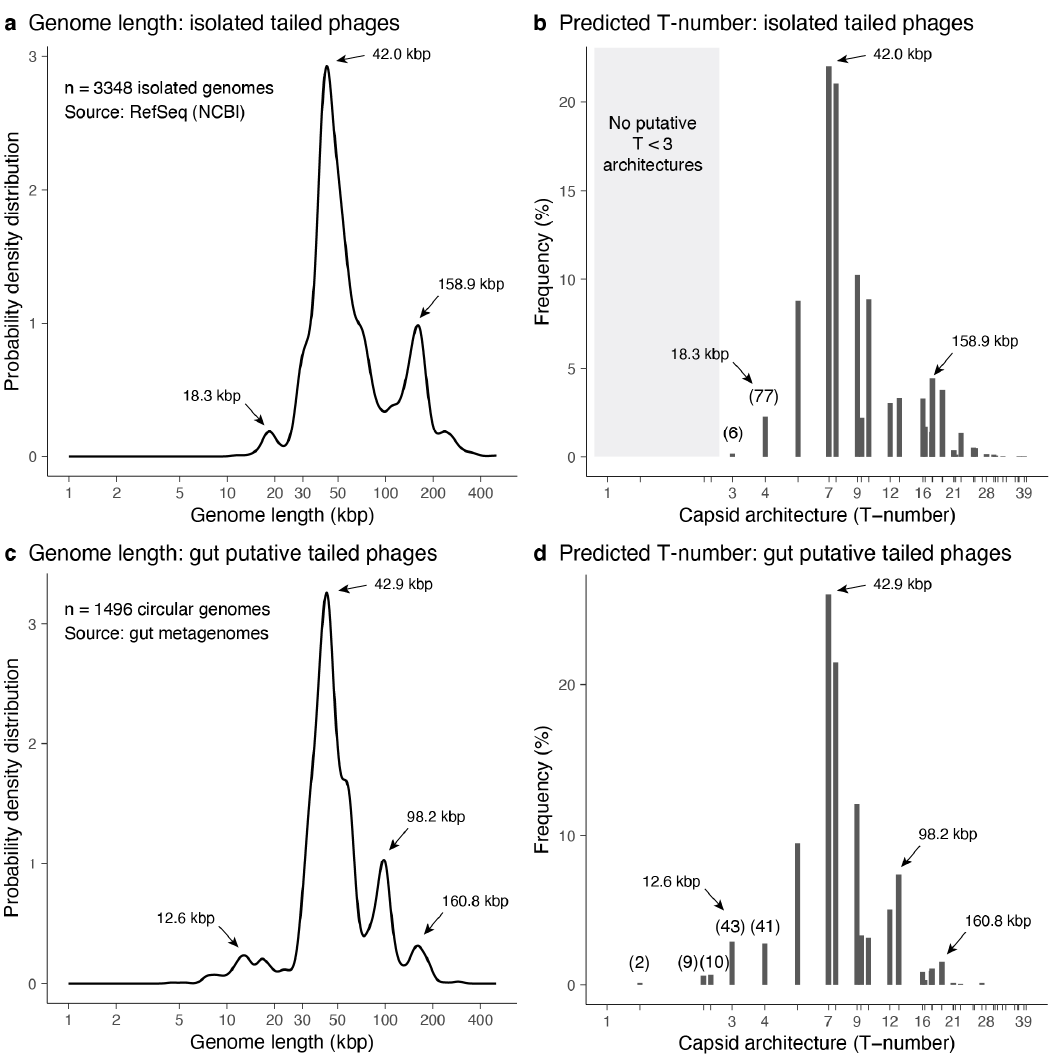
Figure 5. Predicted architectures among tailed phage isolates. ( a ) Genome length distribution for tailed phage isolates obtained from the NCBI Reference Sequence Database. ( b ) Frequency (percentage) of predicted T-number architectures from the genome lengths of isolated tailed phages. The grey area highlights the absence of T < 3 architectures. ( c , d ) Genome length distribution and predicted T-number architectures for putative gut tailed phages. ( a – d ) The arrows indicate the significant peaks of the genome length distribution and the associated T-number architectures. ( b , d ) The parenthesis indicates the number of predicted T ≤ 4 phage capsid architectures.